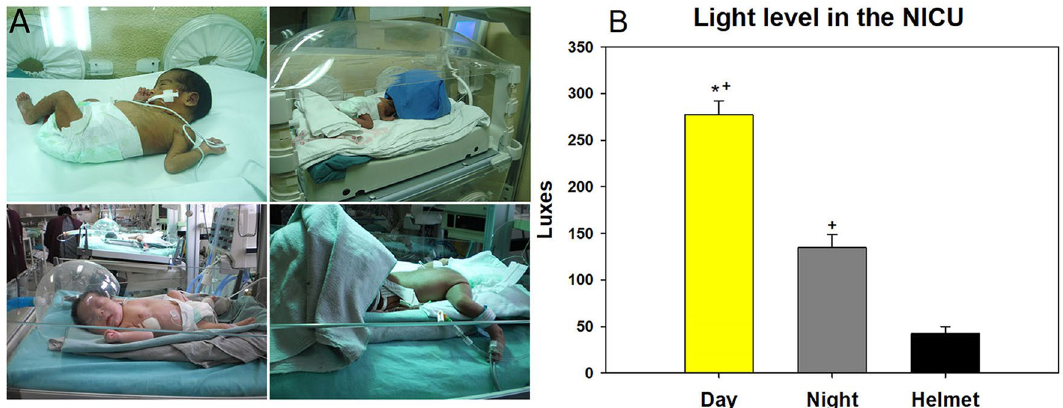
Figure 4. ( A ) Representative images of infants randomized to CBL (left panels) and LDC (right panels). ( B ) Illumination level (measured in Lux mean ± SD) during different conditions in the NICU, including daytime, nighttime, and when using the cephalic helmet for infants randomized to the LDC study group (* p -value < 0·002; + p -value < 0·001 when comparing with the illumination level while wearing the cephalic helmet); (the authors have the consent of the parents of the patients to publish the